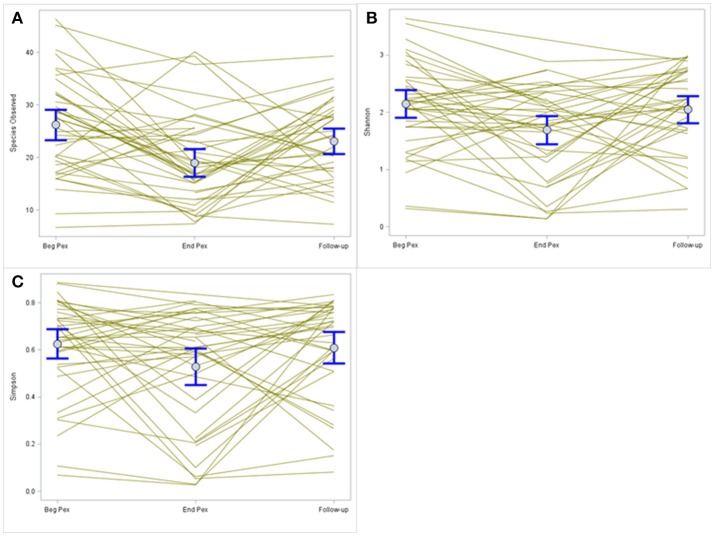
Comparison of alpha diversity over time. Species observed (A) shows a decrease in values after completion of IV antibiotic treatments that increase at follow-up. A similar pattern is observed for the Shannon and Simpson diversity indices (B,C, respectively) but the magnitude of change differs for each index.